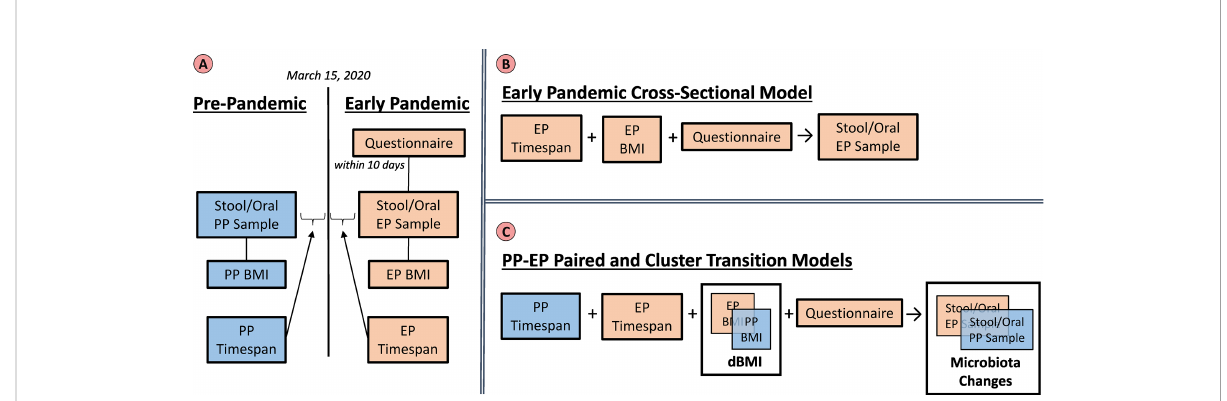
FIGURE 1 Variables and Models. The left panel (A) summarizes the groups of variables that were utilized in the analyses. Pre-pandemic (PP) (blue) and Early Pandemic (EP) (beige) variables include the taxonomic pro fi les from sequencing microbiota samples, BMIs interpolated based on the sample collection dates, and timespans relative to March 15, 2020. The questionnaire responses were only collected during the early pandemic. The top right panel (B) illustrates the early pandemic cross-sectional model. Here, only the EP variables: timespan, BMI, and questionnaire were utilized to build a model to predict the EP stool or saliva microbiota. The lower right panel (C) represents the variables included in the paired and cluster transition models. Both the PP and EP timespans, as well as questionnaire responses were included in the models. The BMI and microbiota pro fi les were included in the model as their relative changes which could be calculated per